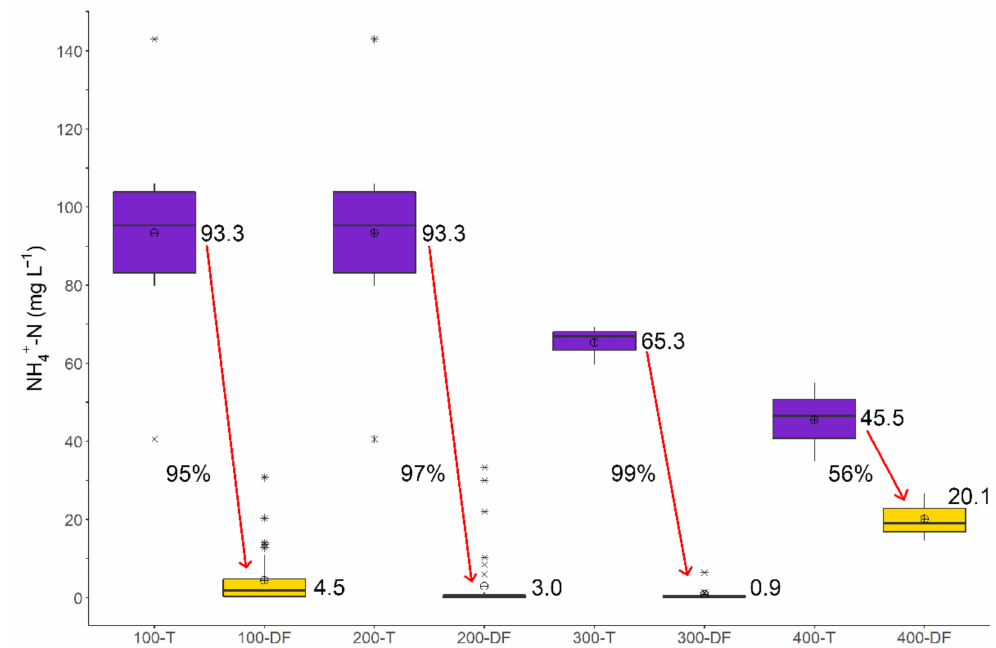
Figure 5. Box plots showing ammonium nitrogen (NH 4+ -N) concentrations in wastewater collected from the septic tanks (T) and groundwater near (<3 m) the drainfields (DFs) at Sites 100 to 400. The treatment efficiencies for the onsite wastewater systems are shown as percentages. Circles indicate mean concentrations, horizontal lines show median concentrations, asterisks are statistical